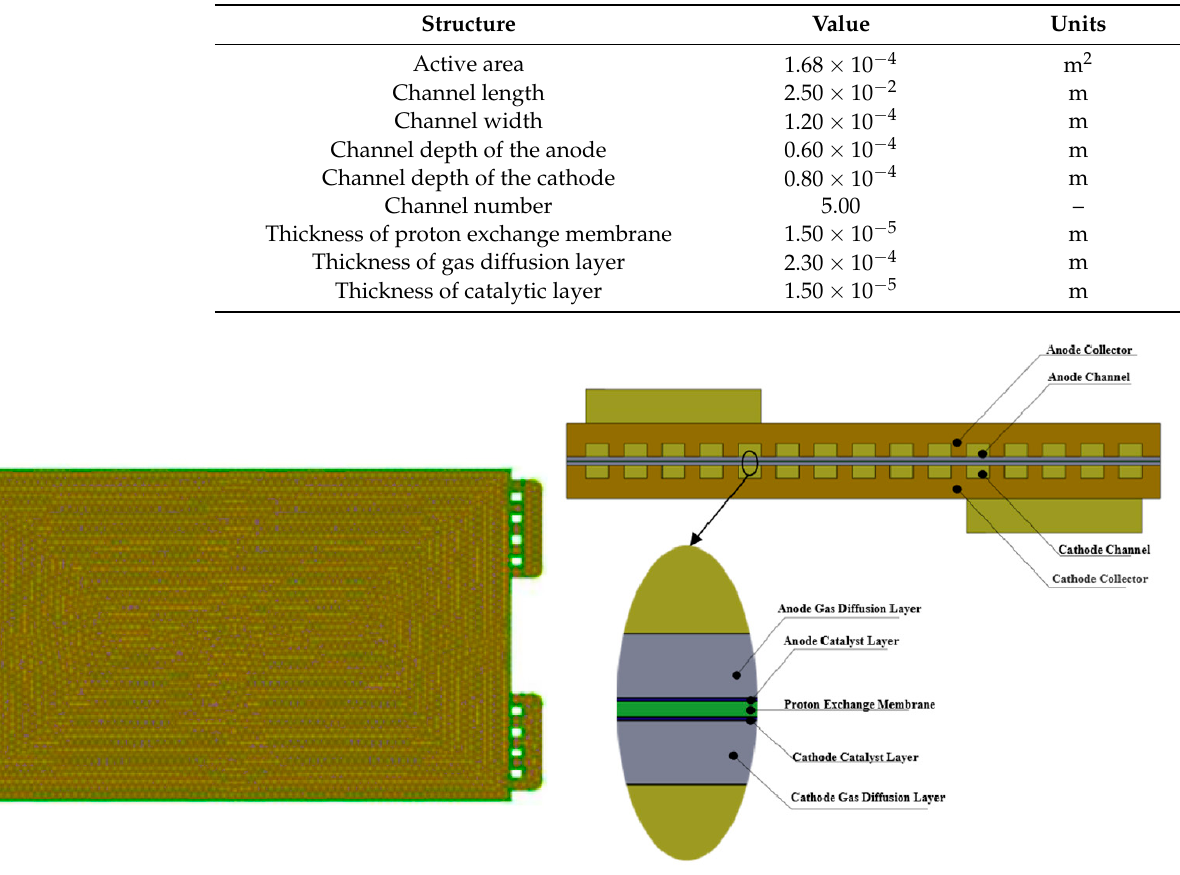
Figure 1. Meshes employed in this model. Table 1. Cell properties of the fuel cell model.